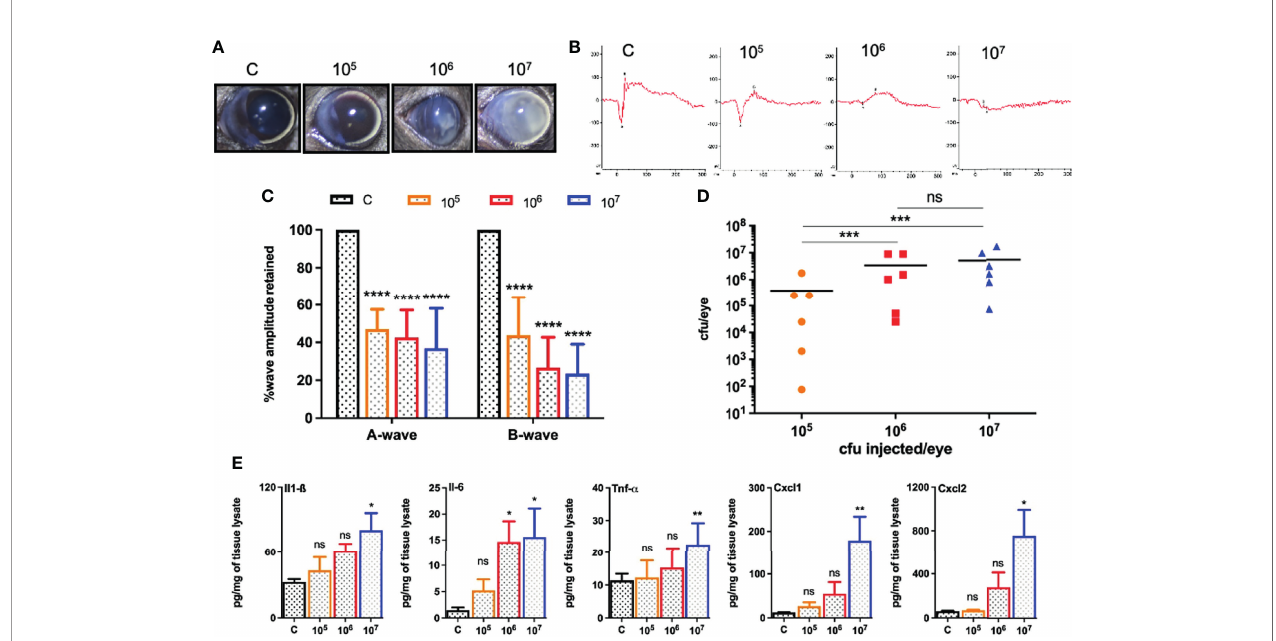
FIGURE 1 | Intravitreal inoculation of S. epidermidis causes endophthalmitis in C57BL/6 mice. C57BL/6 mice eyes (n = 6 eyes each condition) were intravitreally injected with indicated colony forming units (cfu/eye) of S. epidermidis or PBS (control, C), and eyes were processed 24 h post-infection (p.i.). (A) Slit-lamp examination was performed, and photomicrographs were taken from representative eyes showing corneal haze/opacity. (B) Scotopic electroretinogram (ERG) analysis was performed to assess retinal function. (C) Bar graph showing percent a- and b-wave amplitude retained with respect to control eyes set at 100%. (D) At 24 h p.i. eyes were enucleated and homogenized, and the bacterial burden was estimated via serial dilution plating. (E) The lysates from infected and control eyes were subjected to ELISA to quantify protein levels of indicated in fl ammatory mediators. Statistical analysis was performed using ANOVA with Dunnett ’ s multiple comparison test (C, E) or Tukey ’ s multiple comparison test (D) , (*) p<0.05 (**) p<0.01 (***) p<0.001 (****) p<0.0001; ns, nonsigni fi